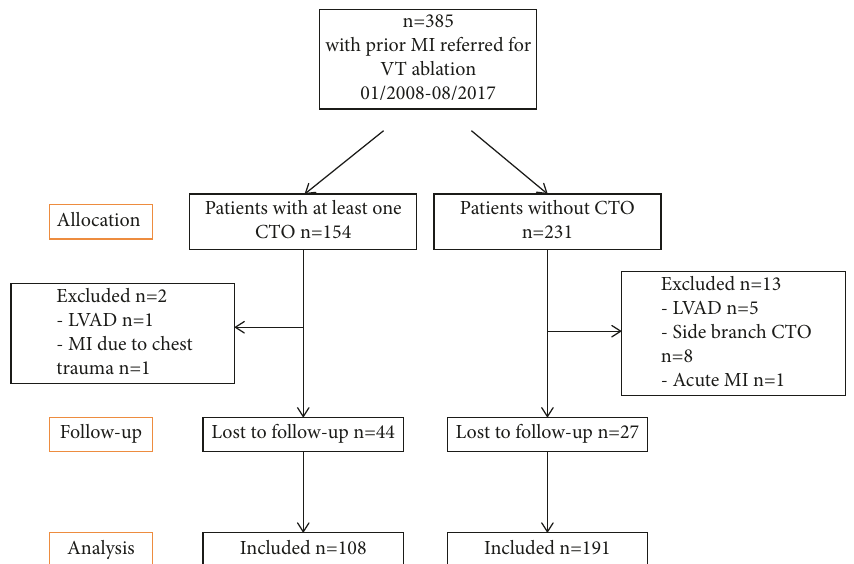
Figure 1: Study flow chart. CTO